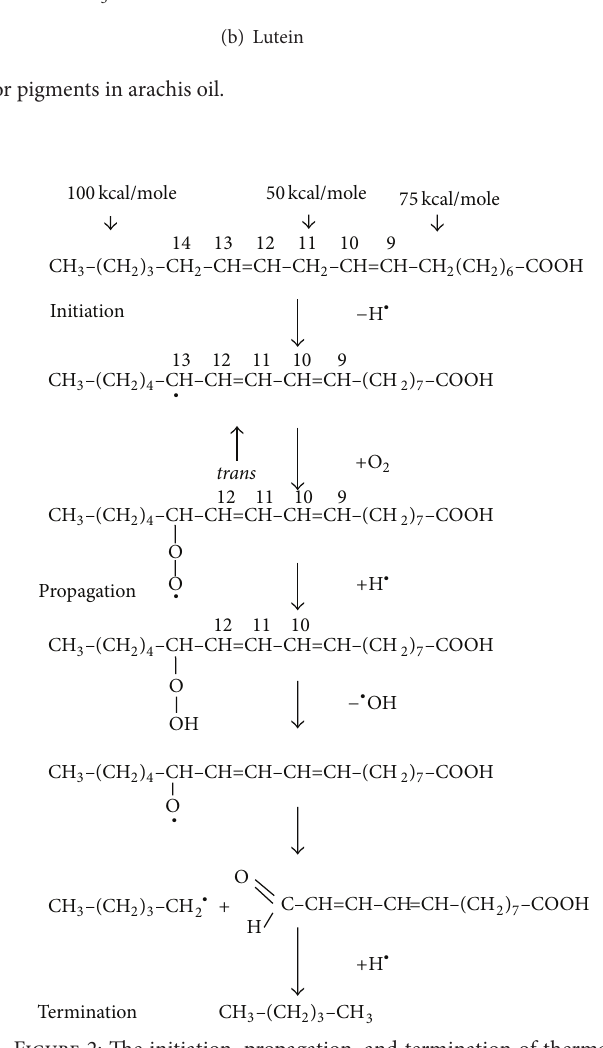
Figure 2: The initiation, propagation, and termination of thermal oxidation of oil. Source: Choe and Min